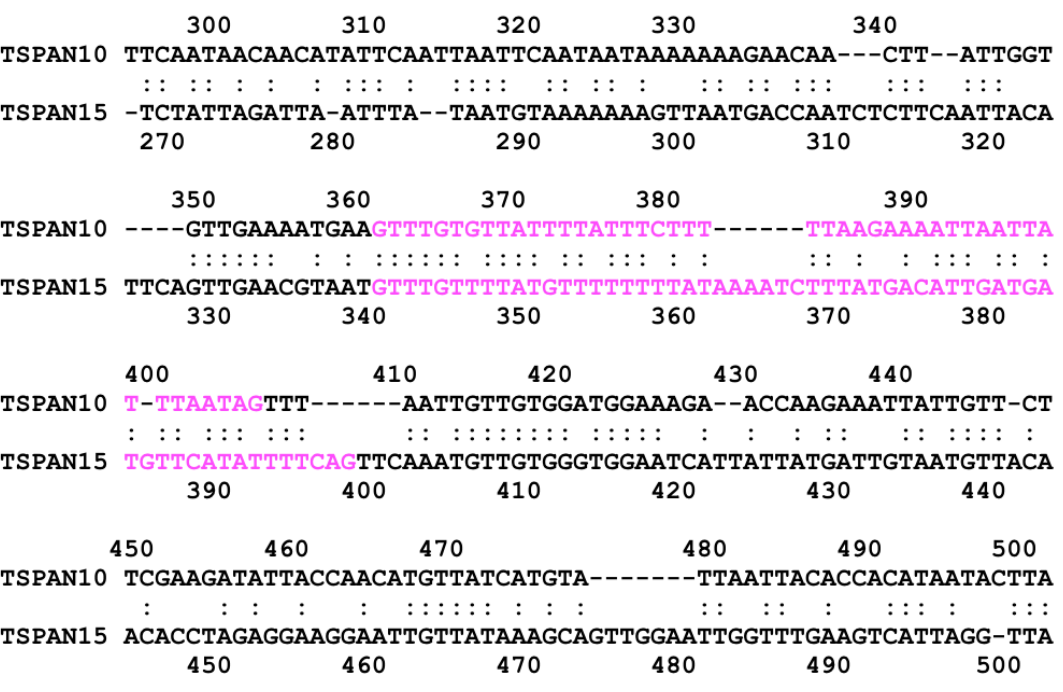
Figure 5. Local alignment of nucleotide sequences between TSPAN10 and TSPAN15 in E. histolytica . Letters in magenta represent intron